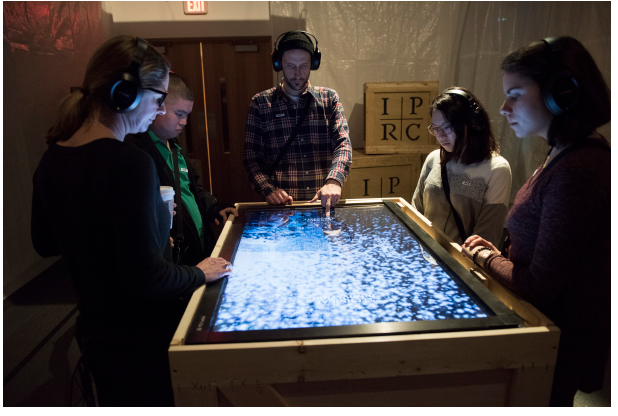
Fig. 2 . Group decision making around the touch-table. (Photo by Emily Cooper.)